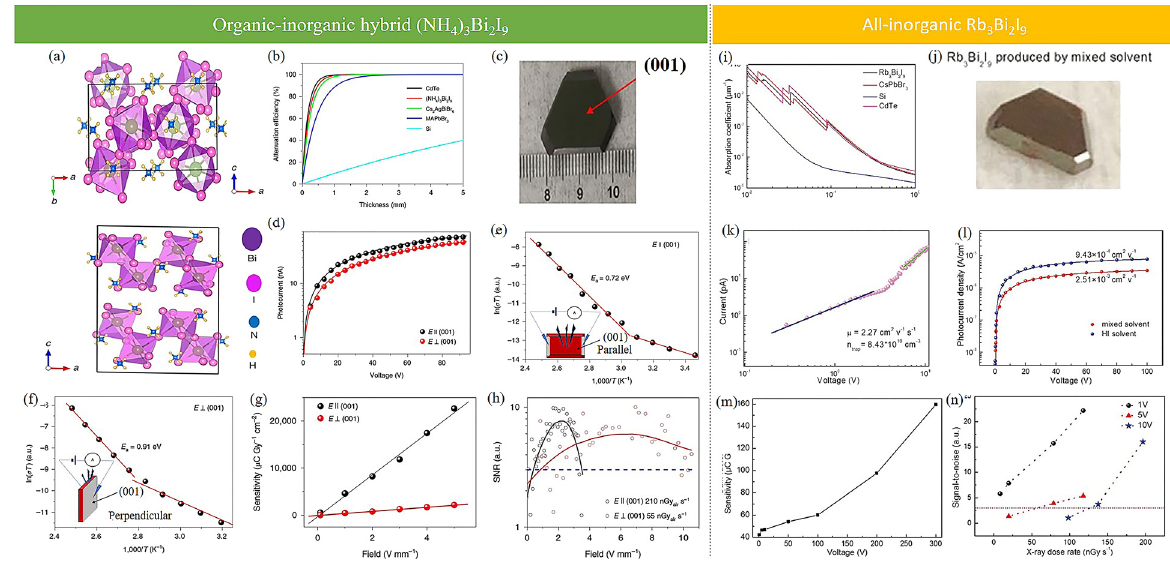
Figure 11: 2D Bi-based perovskite variants for X-ray direction. (a) – (h)characterizetheanisotropicX-raydetectionof(NH 4 ) 3 Bi 2 I 9 .(i) – (n)characterizetheX-raydetectionofRb 3 Bi 2 I 9 .(a)Schematicillustration of the (NH 4 ) 3 Bi 2 I 9 crystal structure along the c and b axes. (b) Comparison of the thickness-dependent attenuation ef fi ciencies of (NH 4 ) 3 Bi 2 I 9 , Cs 2 AgBiBr 6 , MAPbBr 3 , CdTe, and Si towards 50 keV X-ray photons. (c) Photograph of (NH 4 ) 3 Bi 2 I 9 single crystal. (d) Bias voltage-dependent photoconductivity of (NH 4 ) 3 Bi 2 I 9 along the directions parallel and perpendicular to the (001) plane. (e) – (f) Temperature-dependent conductivity of (NH 4 ) 3 Bi 2 I 9 along the derections parallel (e) and perpendicular (f) to the (001) surface for fi tting the activation energy of ion migration.(g)X-raysensitivitiesand(h)signal-to-noiseratio(SNR)oftheAg/(NH 4 ) 3 Bi 2 I 9 /Agdeviceinthedirectionsparallelandperpendicular tothe(001)surface.ThebluedottedlinedenotesabenchmarkSNRof3.Thedetectionlimitsare210 nGy air s − 1 forparalleland55 nGy air s − 1 for perpendicular devices, respectively. Reproduced with permission. Copyright 2019, Springer Nature [30]. (i) The photon energy-dependent absorption coef fi cient of Rb 3 Bi 2 I 9 in comparison with a few representative semiconductors. (j) Photograph of the solution-grown Rb 3 Bi 2 I 9 single crystal. (k) I – V curve fi tted by the space charge-limited current (SCLC) model. (l) Photoconductivity of the Rb 3 Bi 2 I 9 single crystal to calculatethe μτ product.(m)Thedependenceof X-raysensitivity onthebias voltage.(n)Signal-to-noiseratioofthedeviceupondifferentbias voltages. The dashed line represents the baseline ratio of 3 according to the IUPAC de fi nition. Adapted with permission. Copyright 2020, Wiley-VCH Verlag